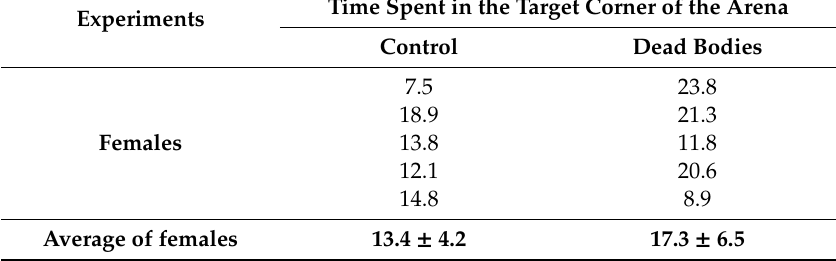
Table 3. Time any individual spent in the target corner of the arena before and after the addition of the intact dead bodies. Males and females were tested in separate experiments. Total observation time = 25 min, Group size = 5 individuals, N =